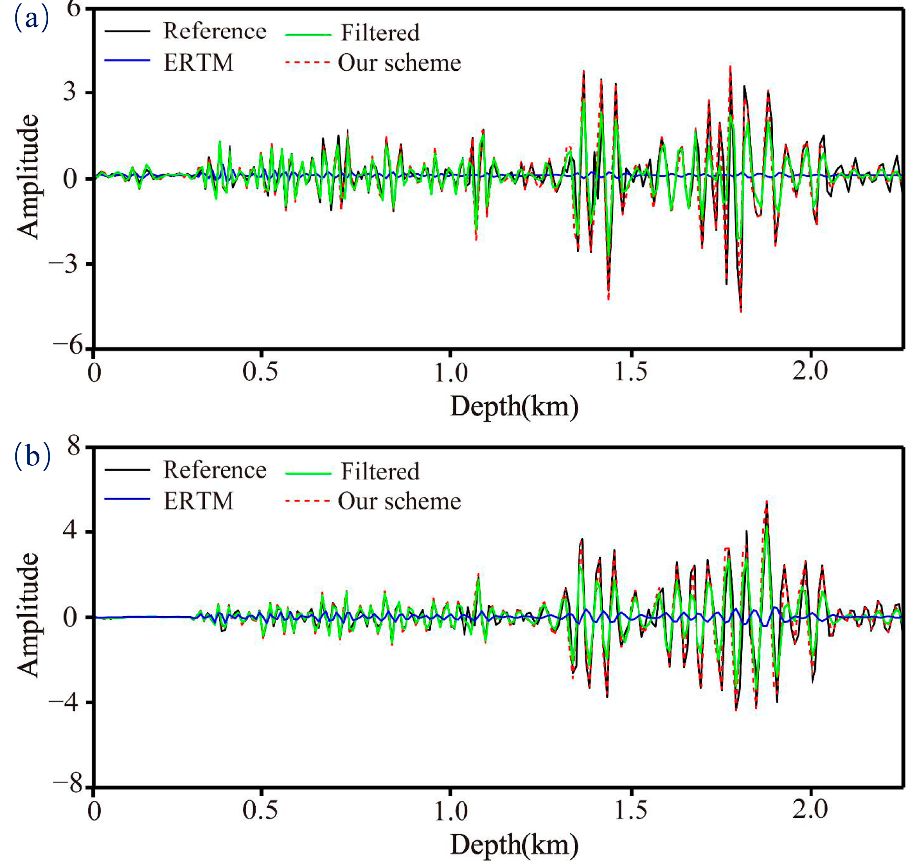
− component ( b ) PS-component.